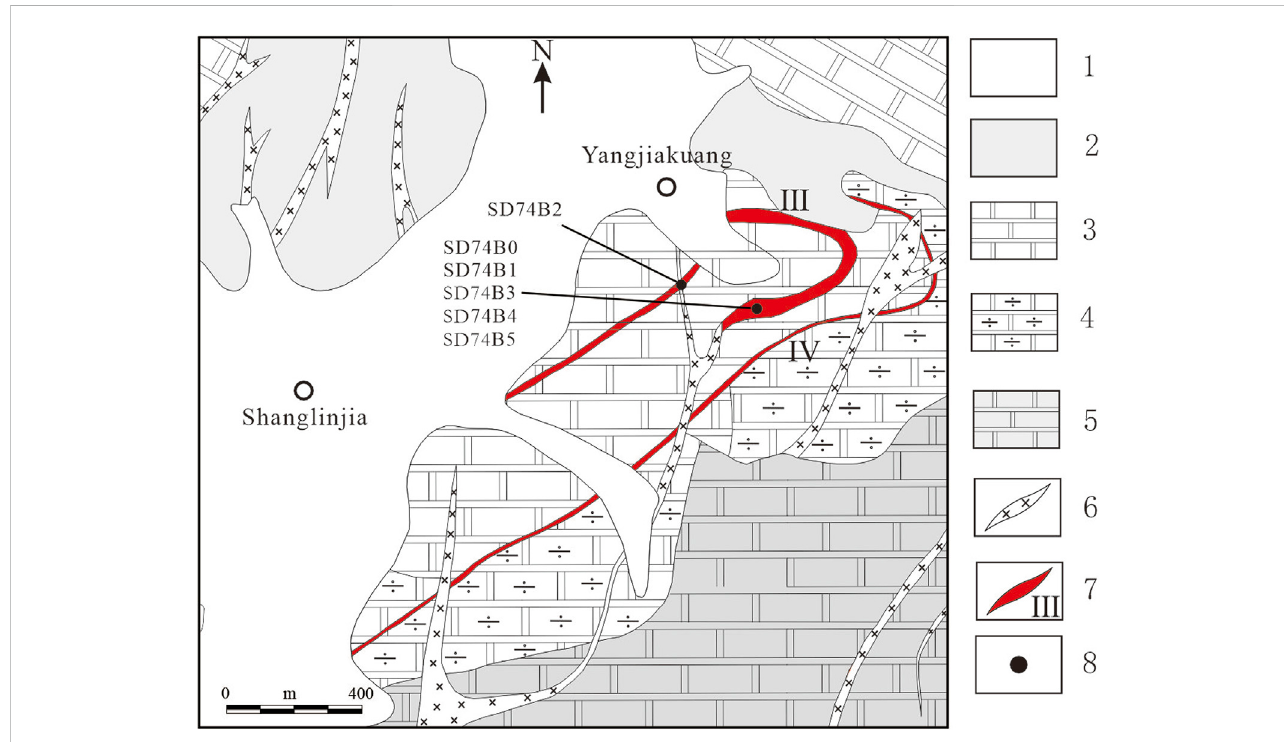
FIGURE 2 Geological sketch map of the Yangjiakuang gold deposit (after Ding, 2014). 1. Quaternary; 2. Slate (Baoshankou Formation); 3. Dolomite marble (Third member of the Zhanggezhuang Formation); 4. Diorite marble (Second member of the Zhanggezhuang Formation); 5. Dolomite marble (First member of the